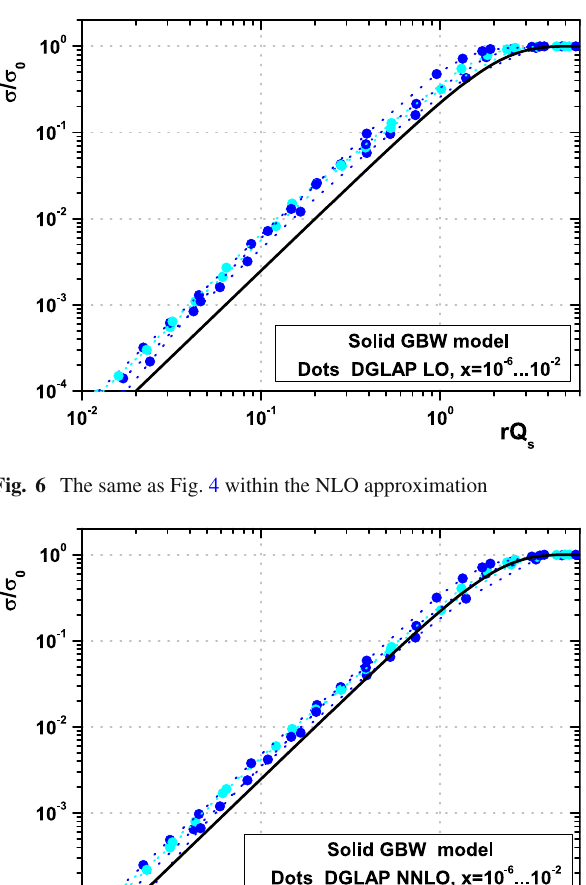
Fig. 4 Comparison of the “order / GBW” obtained by the ratio σ dip /σ 0 at x = 10 − 6 in a wide range of r at LO up to NNLO approximations, respectively